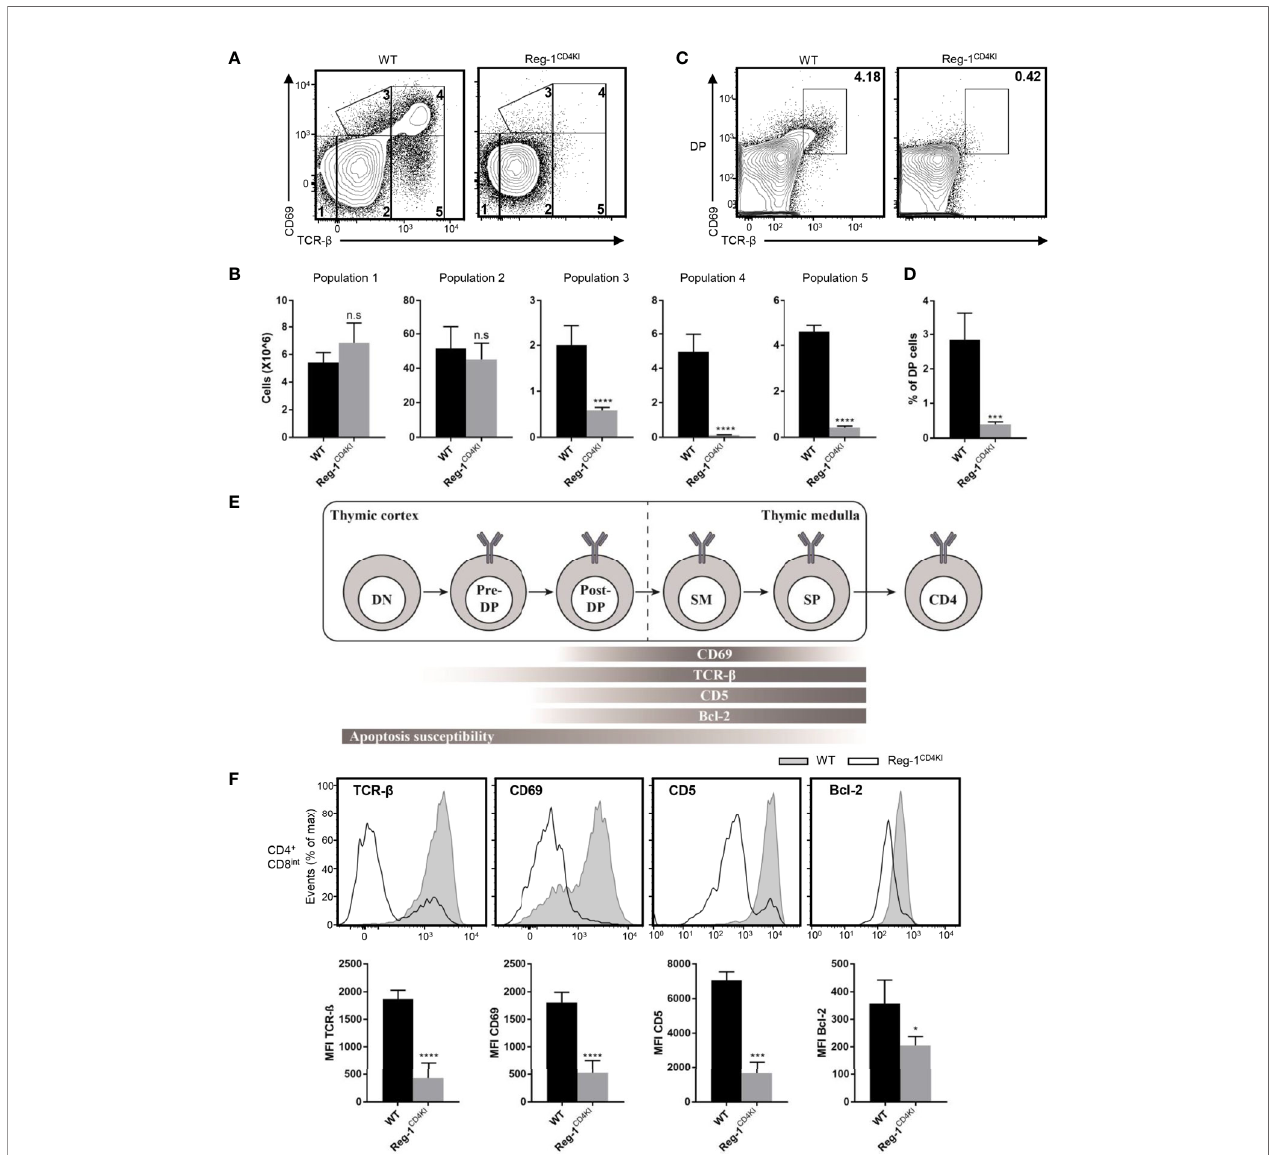
FIGURE 6 | Mutant Regnase-1 impairs thymocyte positive selection in vivo . (A) Flow cytometry analysis of the surface expression of CD69 and TCR- b on WT or Reg- 1 CD4KI thymocytes, gated on CD45 + alive cells. The number in outlined area indicates fi ve subpopulations during thymocytes development. (B) Bar graphs representing the number of fi ve subpopulations at different stage during T cell development in WT or Reg-1 CD4KI thymus. (C) Flow cytometric analysis of DP thymocytes through thymic positive selection based on the expression of CD69 and TCR- b , gated on CD45 + DP thymocytes. (D) Bar graph indicates the percentage of post-selection DP (CD69 + TCR- b hi ) thymocytes. (E) Schematic graph of CD4 + T cell development in thymus. T cells undergo differentiation from DN to DP to CD4 or CD8 single positive cell, accompanied with changes of several surface and intercellular markers (Pre-DP: pre-selection double positive cells; Post-DP: post-selection double positive cells; SM: susceptible to apoptosis mature cells). (F) Flow cytometric analysis and mean fl uorescence intensity of TCR- b , CD69, CD5 and Bcl-2 in gated CD4 + CD8 int thymocytes from WT or Reg-1 CD4KI mice. Data are mean ± SD (n=5) from one experiment, representative of three independent experiments. n.s not signi fi cant; * P < 0.05; *** P < 0.001; **** P < 0.0001 (unpaired two-tailed Student ’ s t